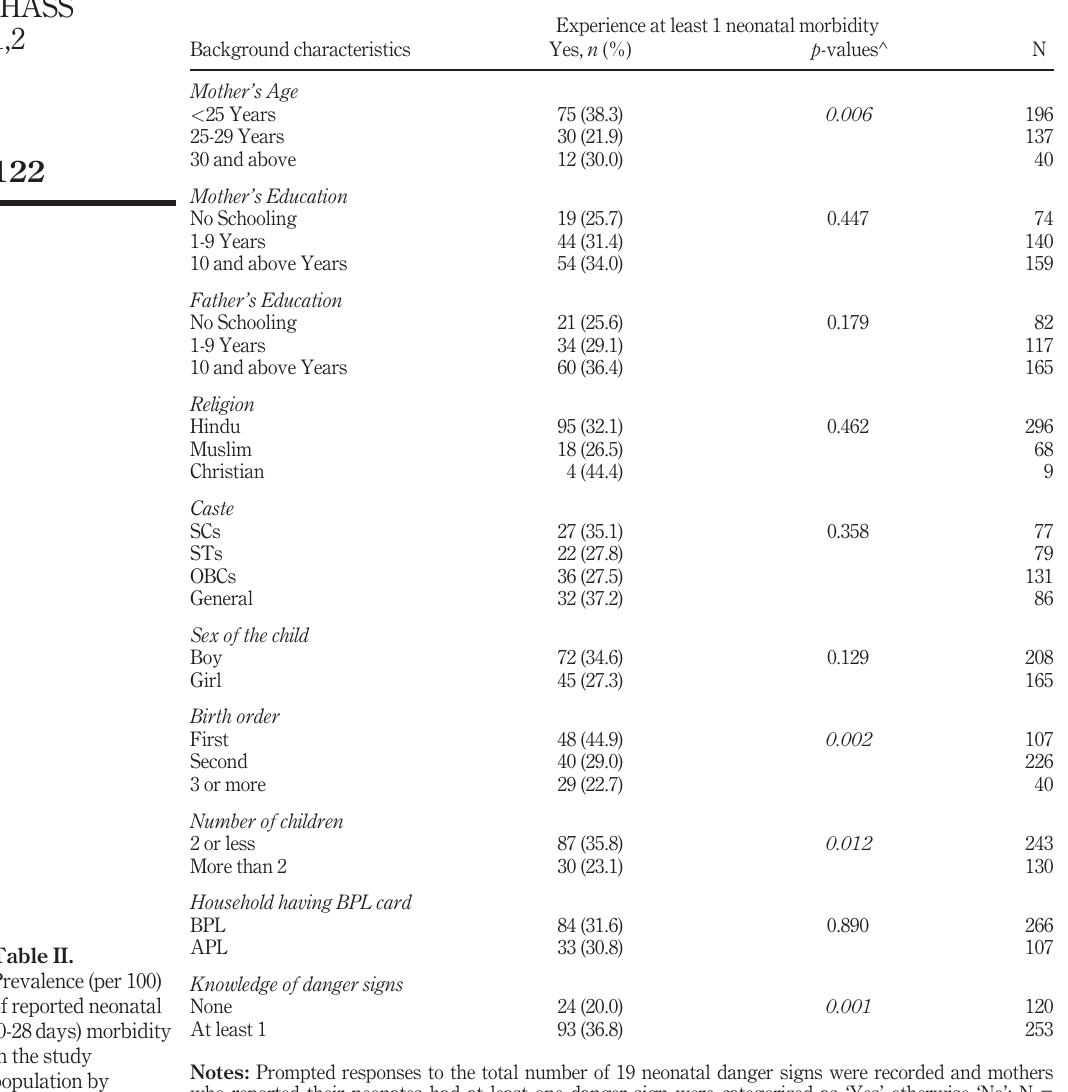
Table II. Prevalence (per 100) of reported